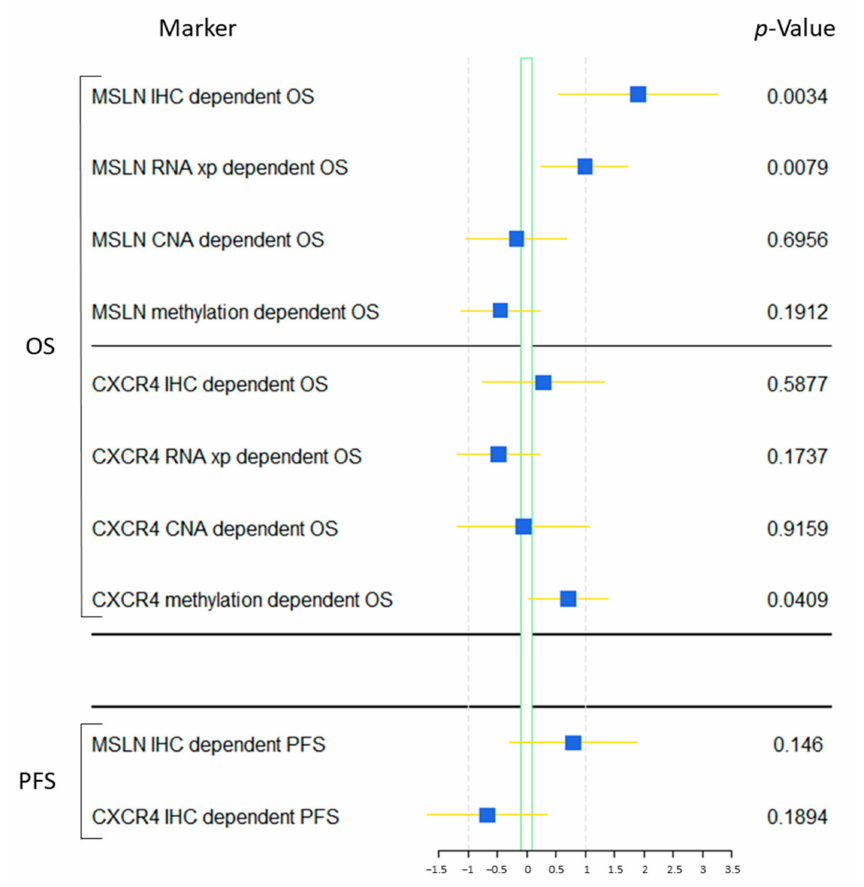
Figure 4. Impact of MSLN and CXCR4 expression, CNA and methylation parameters on overall and progression-free survival. This forest plot shows associations of protein expression of MSLN and CXCR4 on overall survival (OS) as well as progression-free survival (PFS) of the investigated patients. In addition, gene expression, CNA, and methylation data of CXCR4 as well as MSLN from the TCGA data base were analysed with survival